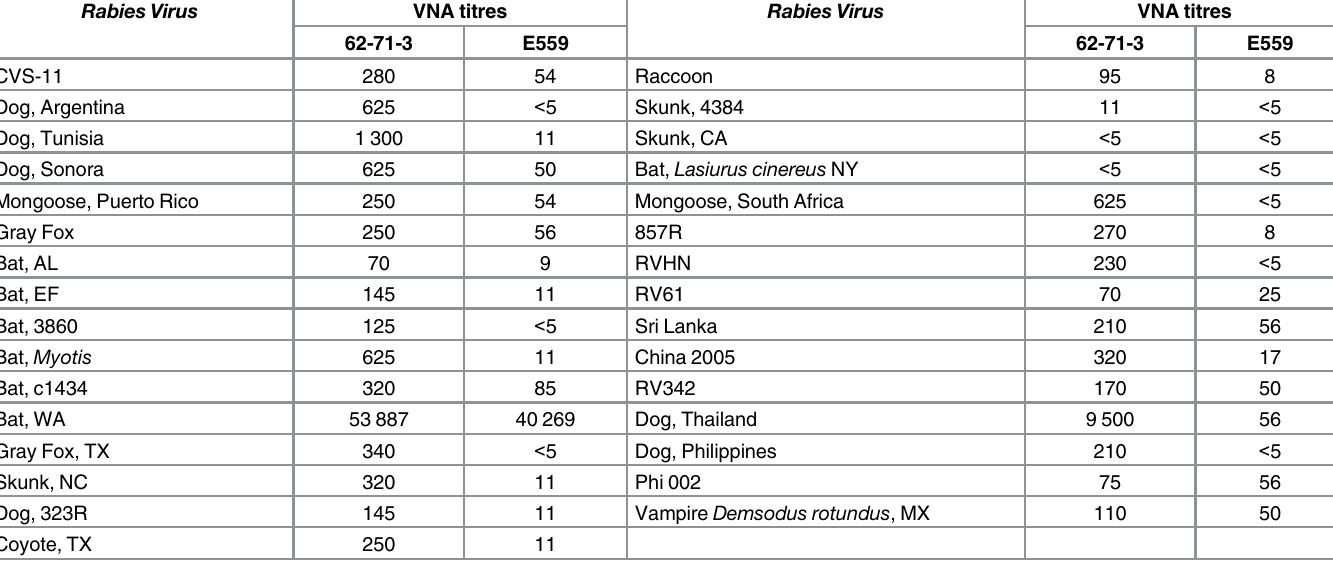
Table 2. Fifty percent end-point neutralisation activity (reciprocal titre) of E559 and 62-71-3 in a modified Rapid Fluorescent Focus Inhibition Test (RFFIT). Rabies